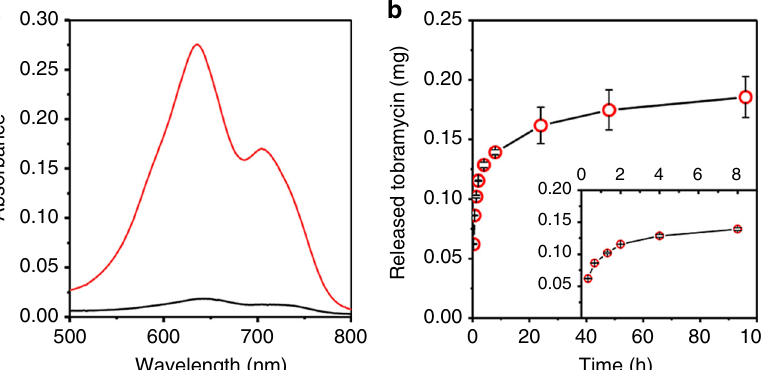
Fig. 3 Loading and release of toluidine blue (TB) and tobramycin. a Absorption spectra of TB released after 4 days of dialysis and 1 M HCl treatment for mesoporous silica particles with (red) and without (black) an initial copolymer shell. b Drug release curve showing the amount of tobramycin released from drug-loaded mesoporous silica particles without coploymer shell at various times. The release curve for the fi rst 8 h is given in the inset. Each data point is the average of two independent experiments and error bars represent